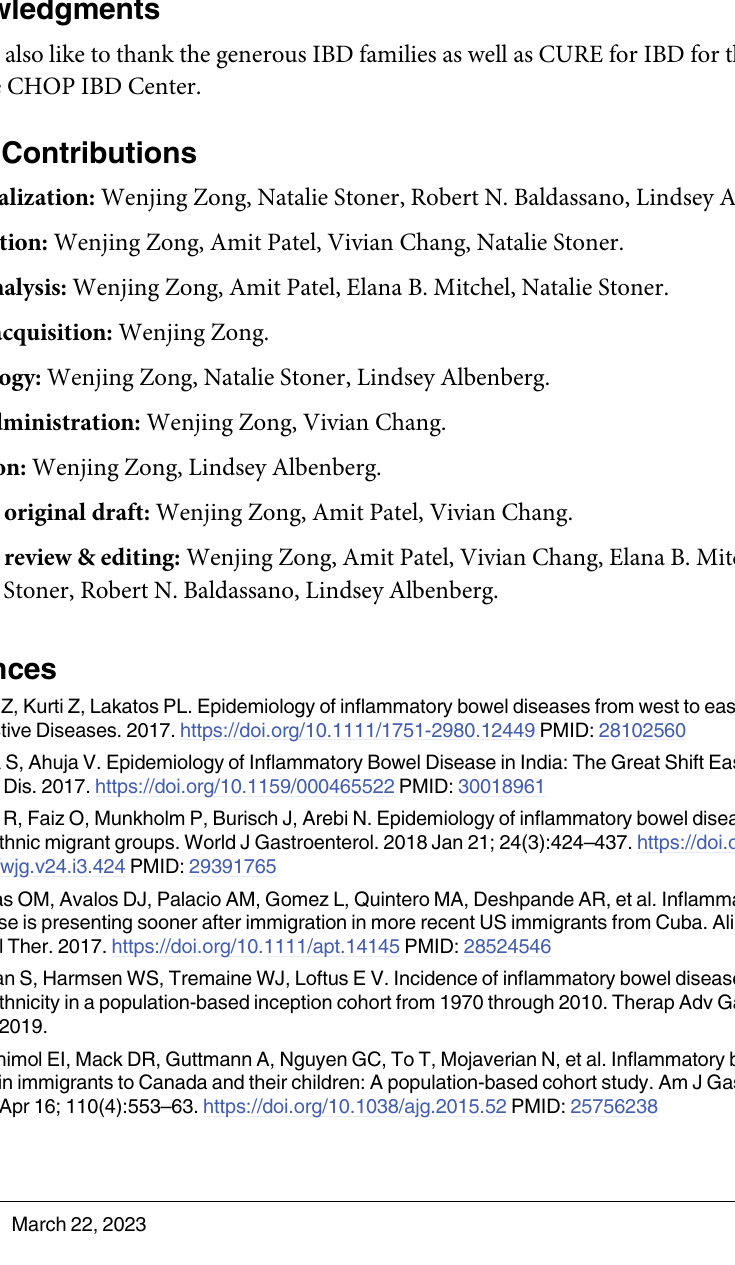
S1 Fig. Analysis of Vitamin D level. Regression models show that vitamin D levels and CRP are inversely correlated, but not for other markers of inflammation. Vitamin D levels have no significant correlation with time of the year in our cohort.